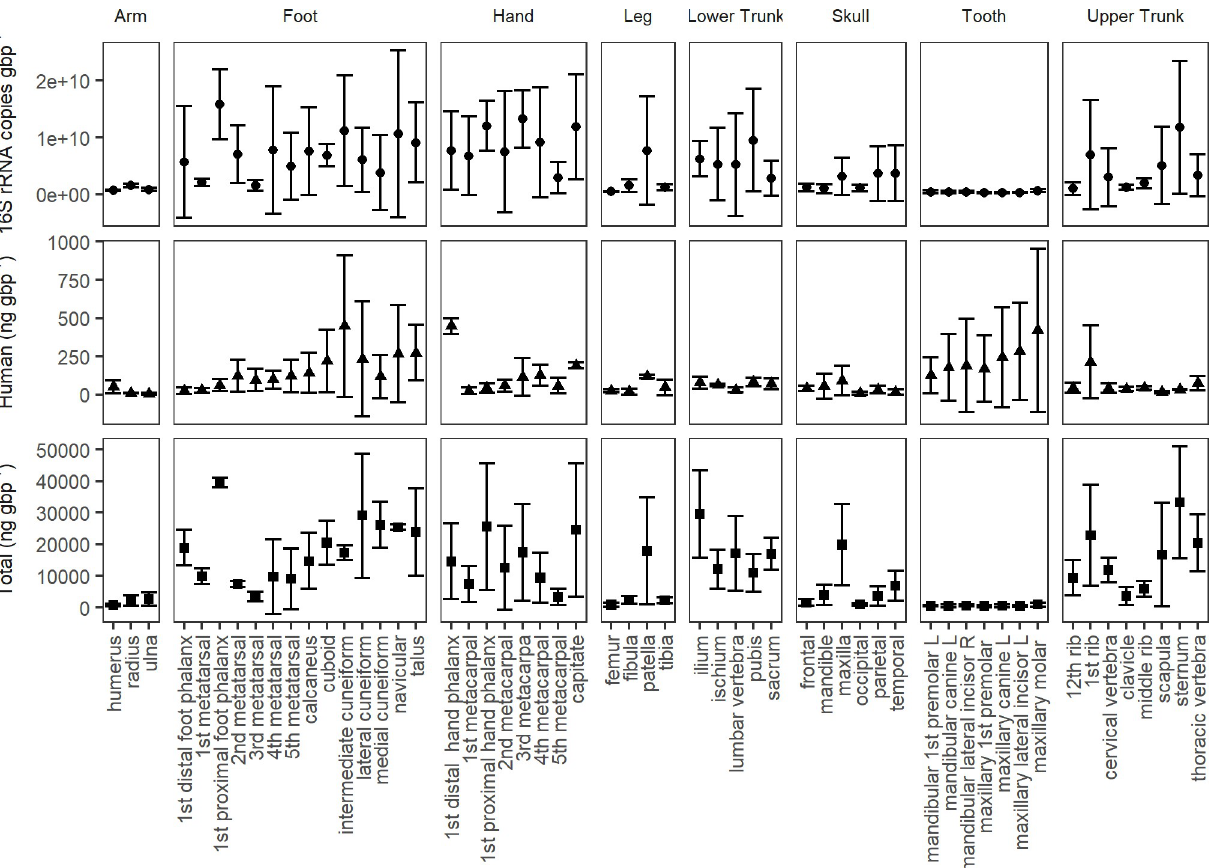
Fig 1. Mean total DNA (total (ng gbp -1 )) or the concentration of DNA extracted, mean human DNA concentration (human (ng gbp -1 )), as quantified using qPCR, and bacterial gene copies (16S rRNA copies gbp -1 ), quantified using qPCR by bone type (n = 3 individuals). Concentrations are presented as nanograms (ng) per gram of bone powder (gbp -1 ). Bars represent standard deviations where n = 3.